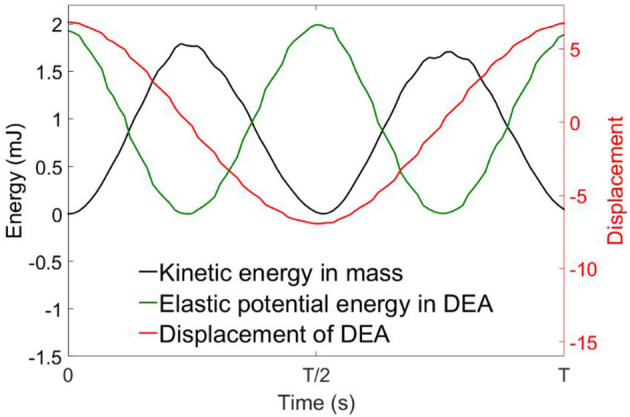
Time series of the displacement, kinetic energy of the mass and elastic potential energy in the DEA membrane at its resonance. Kinetic energy and elastic energy are 90° out-of-phase.